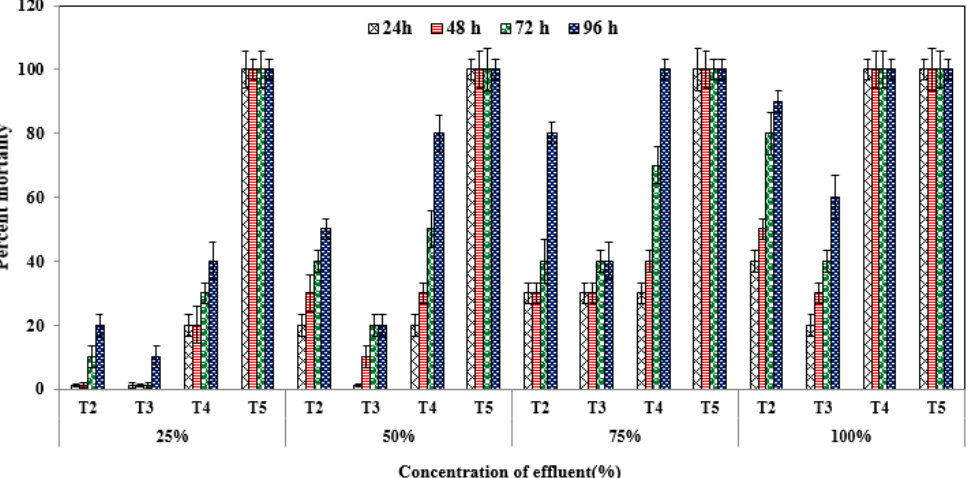
Figure 2. Mortality in fish on exposure to different concentrations of untreated and treated effluent by CWs using Leptochloa fusca. Tannery effluent treated in CWs with L. fusca only (T2), effluent treated in CWs with L. fusca and bacteria (T3), effluent treated in CWs without vegetation (T4), and raw tannery effluent (T5). Each value is mean ± standard error and number of replicates for each treatment ( n ) = 3.